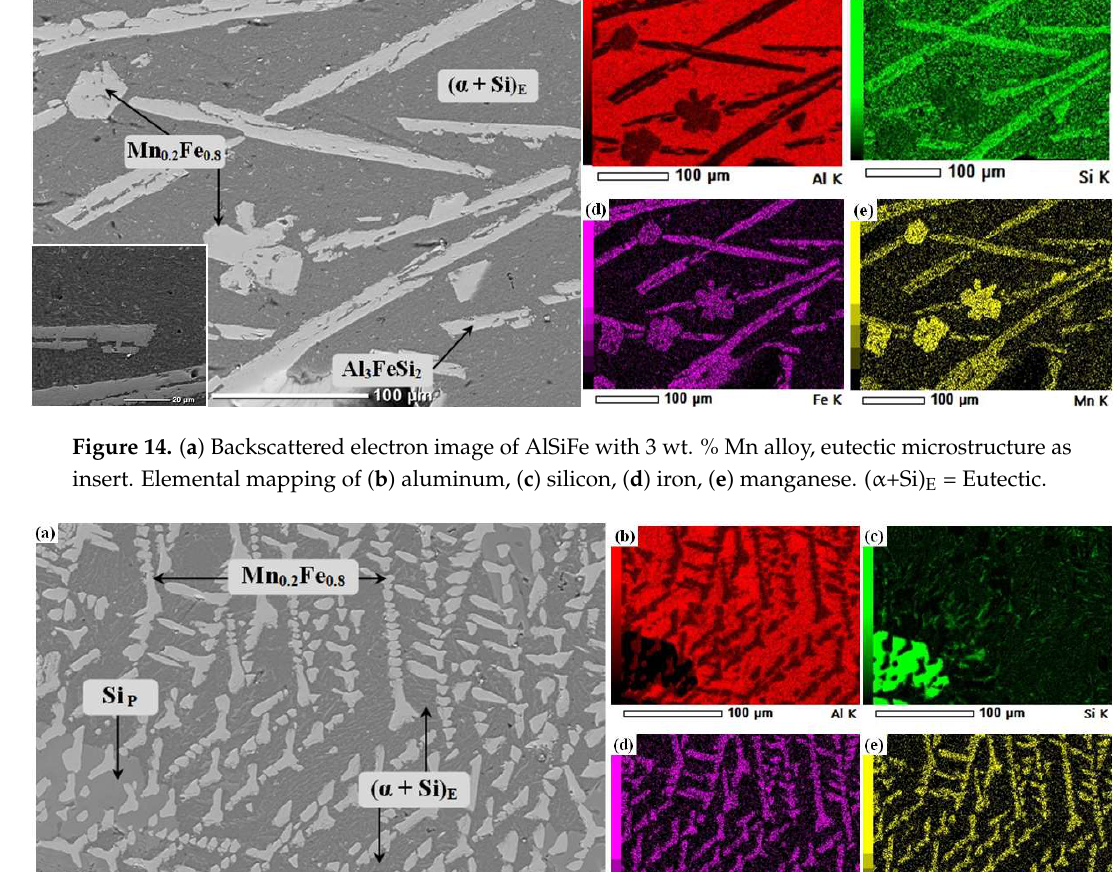
Figure 13. ( a ) Backscattered electron image of AlSiFe with 1 wt. % Mn alloy. Elemental mapping of